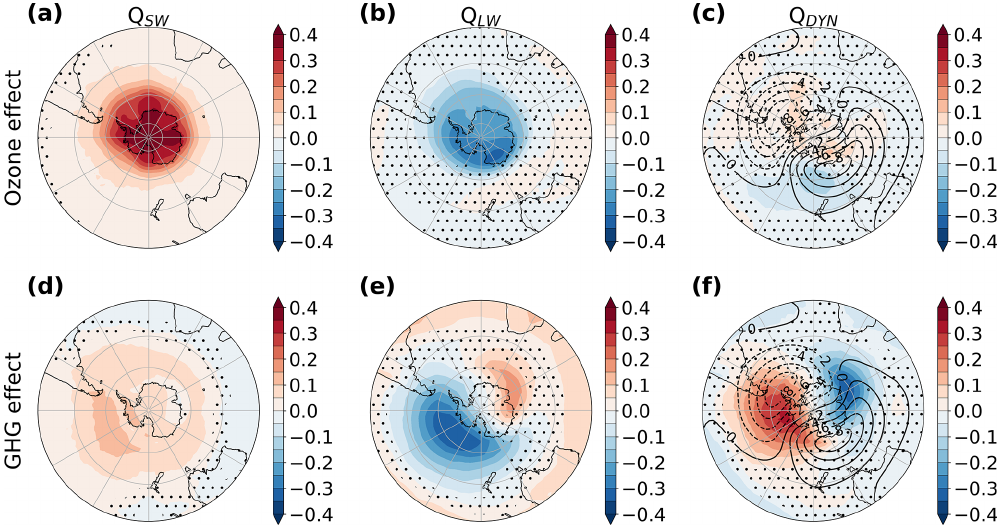
Figure 8. Changes in the SW (a, d) , LW (b, e) , and dynamical (c, f) heating rates (Kd − 1 ) at 50hPa during October due to ozone recovery (a– c) and GHGs (d–f) . The contours in panels (c) and (f) depict the current-day (2011–2030) climatology of the temperature deviations from the zonal mean from INTERACT_O 3 . The stippling masks regions where the changes are not significant at the 95% confidence interval based on a two-tailed t